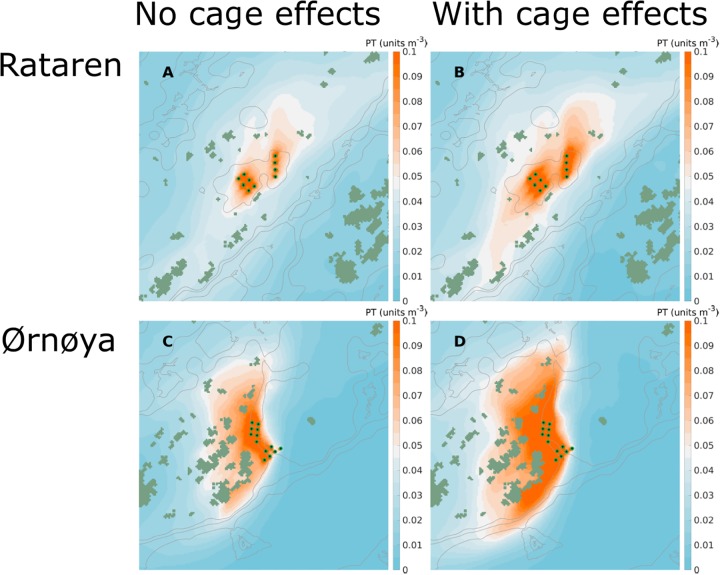
Average simulated dispersal of passive tracers in May-June, 2016.Simulated dispersal of passive tracers from the Rataren (A, B) and Ørnøya (C, D) farms with (B, D) and without (A, C) including the effects of the cages. The results are depth integrated (0 –10 m) means (24 d) of passive tracer concentrations. The gray curves in the background are 30, 50 and 100 m isobaths. The release points of the passive tracer are indicated by green-black dots.